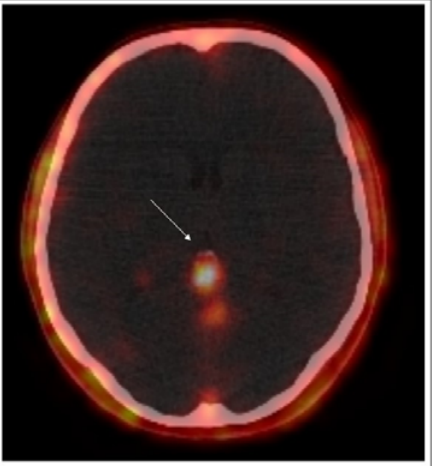
Figure 2. PET/CT test (68Ga-DOTA-peptide). The arrow indicates the increased somatostatin receptor expression in the pineal gland.